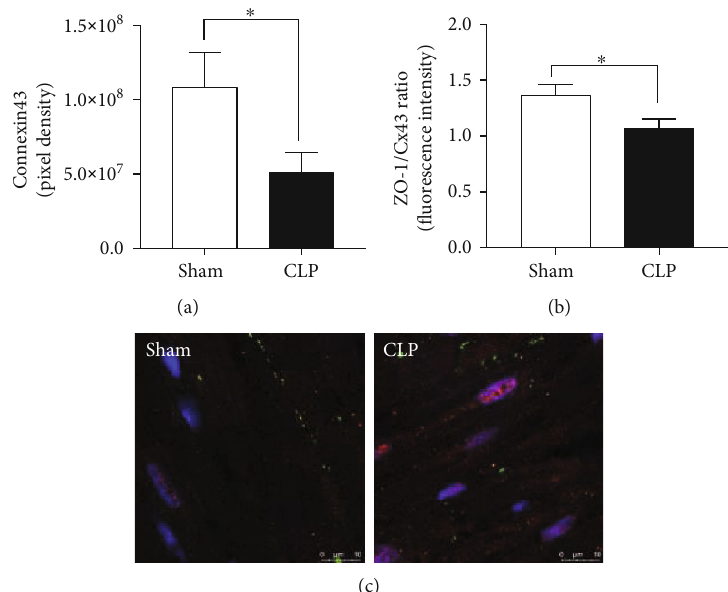
Figure 3: Alterations of cardiac gap junction proteins in vivo in left ventricles of CLP mice: expression of connexin43 in pixel density (a), ratio of the colocalization of zonula occludens-1/connexin43 (b), and representative picture of colocalization of zonula occludens-1/connexin43 (c). Mice received either sham treatment (white bars) or CLP treatment (black bars) for 24h. Left ventricles were collected 24 h after treatment. n = 5 animals per group; ∗ p < 0 : 05 . All values are expressed as mean ± SEM